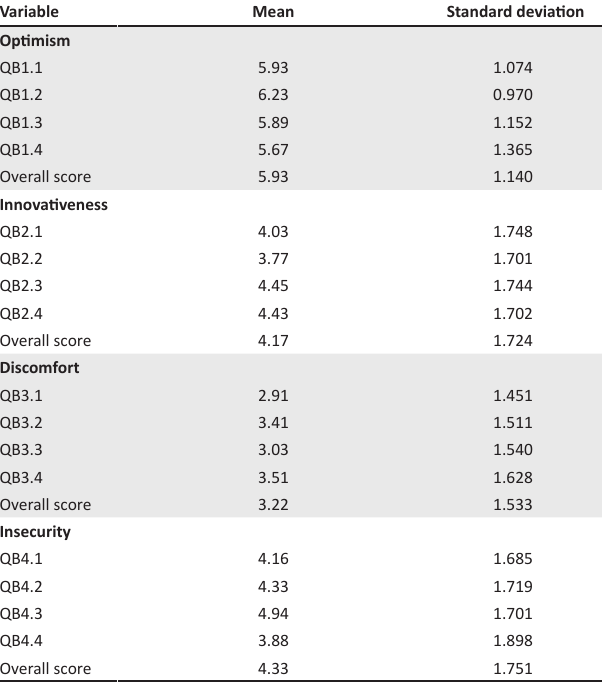
TABLE 1: Descriptive statistics for the dimensions of technology readiness. Variable Mean Standard